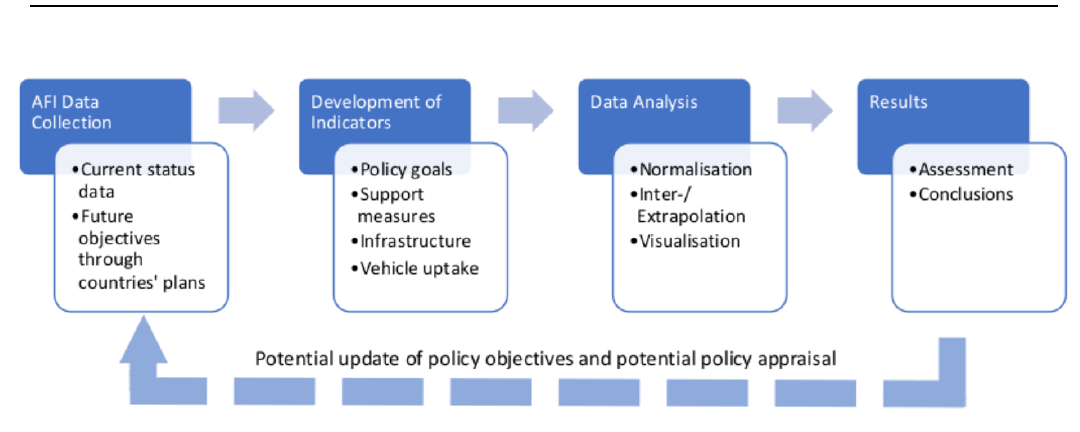
Figure 1. Methodological steps of the analysis.